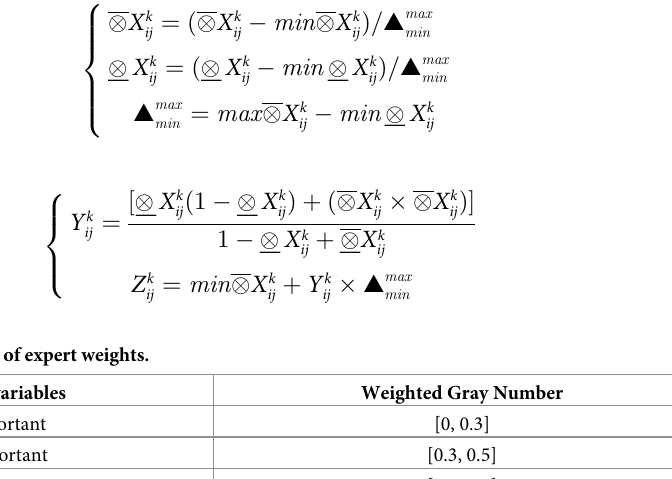
The direct influence matrix obtained by expert scoring is transformed into grey number matrix B by using interval grey number. This is, according to the expert evaluation grey num- ber semantic variable table ( Table 6 ), the value scored by the expert is transformed into the corresponding interval grey number, in which the interval grey numbers on the diagonal are [0,0]. The Gray number matrix B obtained in step 2 is normalized according to Eq (1), and then clarified according to Eq (2) to derive the direct influence matrix Z for each expert clarity k value, k is the number of expert numbers. Similarly, the given expert weights are clarified to derive the specific expert weights W , k is the number of expert numbers. k